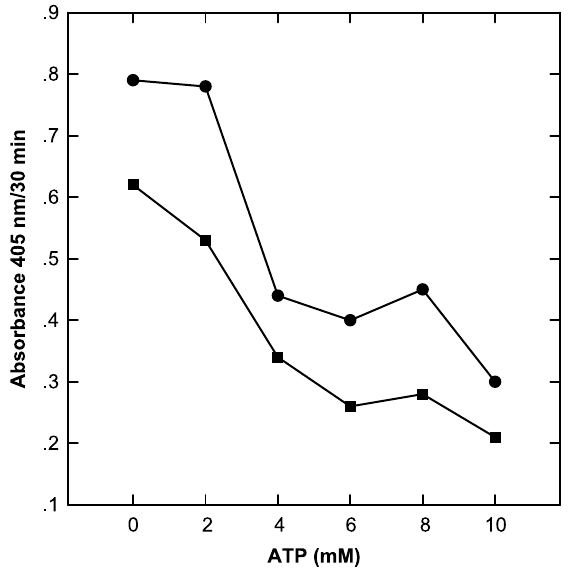
Figure 3. The binding to PA of antibodies from the serum (dilutions 1:400 and 1:800) of an APS patient in the presence of 0– 10mM of ATP. The results indicate that significant inhibition of antibody binding was achieved at concentrations exceeding 4mM